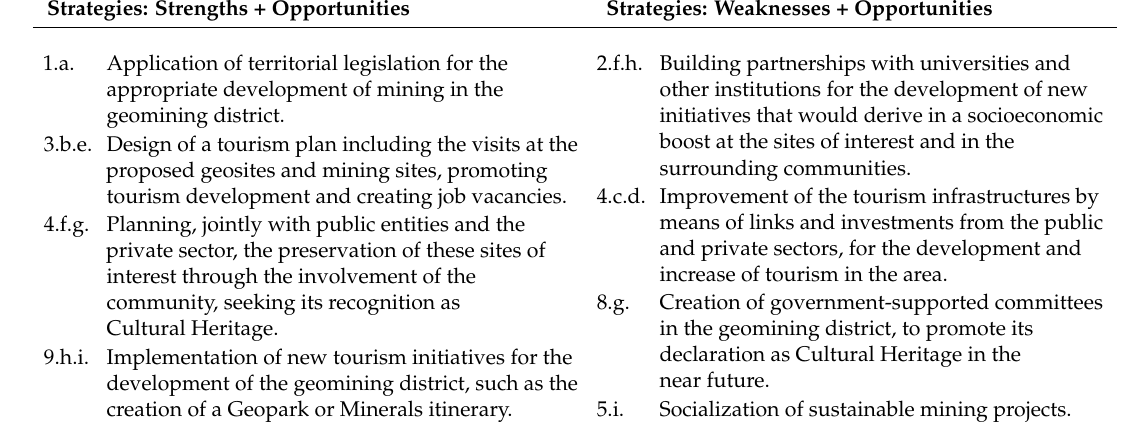
Table 7. TOWS matrix developing strategies based on data from Table 6. TOWS matrix combining internal features (i.e., strengths and weaknesses) identified by numbers 1 to 9 in Table 6 and external features (i.e., opportunities and threats) identified by letters (a) to (i) in Table 6. Strategies: Strengths +